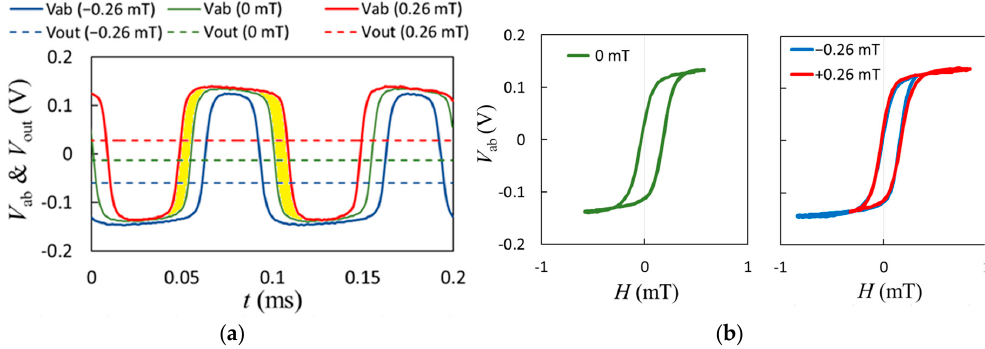
Figure 4. ( a ) Observed time traces of a GMR sensor; ( b ) V-H curves of the direct output for a GMR